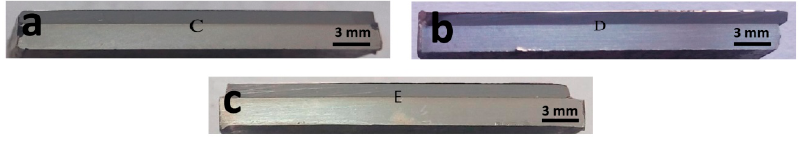
Figure 7. Weld cross-section morphology of VDW. ( a ) AZ31/DP600; ( b ) AZ31/ non-zinc-coated DP600; ( c ) Mg/DP600.